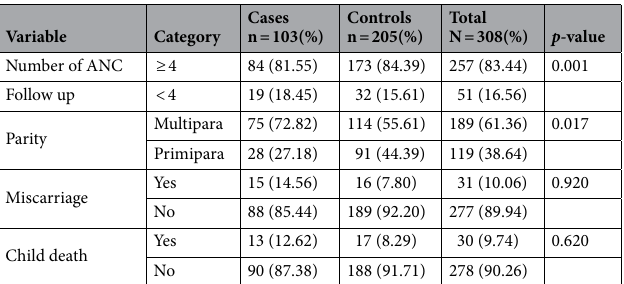
Table 2. Past obstetrics characteristics of mothers who delivered at Ilu Aba Bor, in Public Hospitals, Ethiopia, 2021.